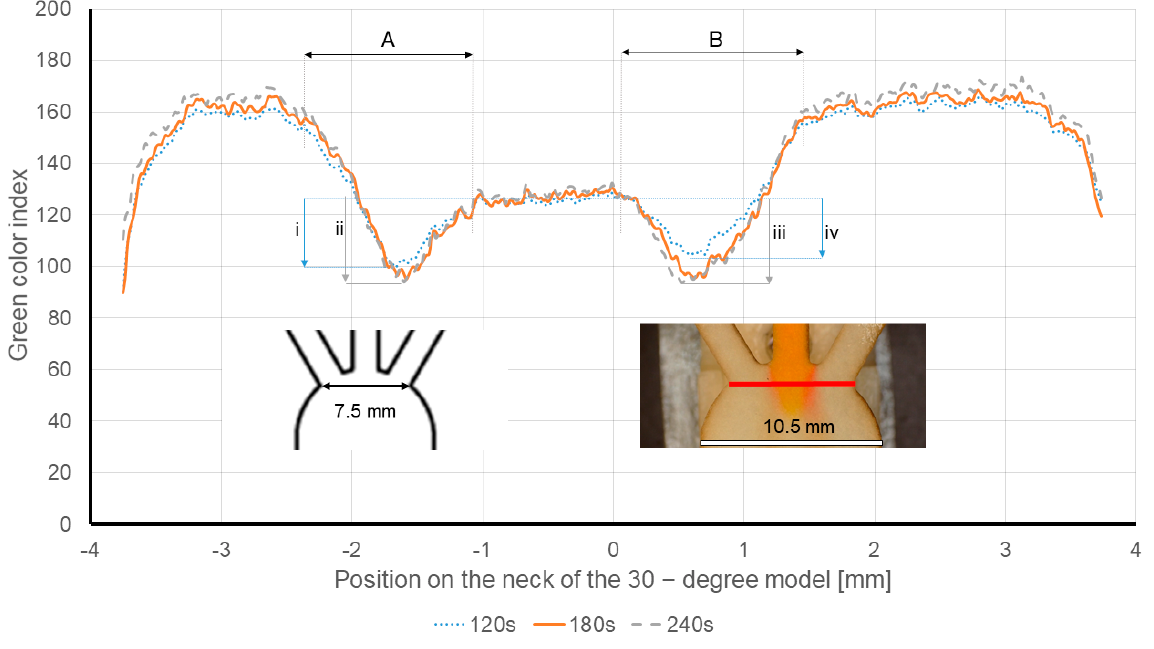
Figure 12. Intensity of the green channel of the diffusion on the measurement line at 120, 180 and 240 s after the time zero. Wine is injected through the left inlet and 0.1 M tartaric acid solution is entered via the right inlet. Red line shows the new measurement line at the neck of the 30-degree model. The dimensions are also illustrated in the pictures.